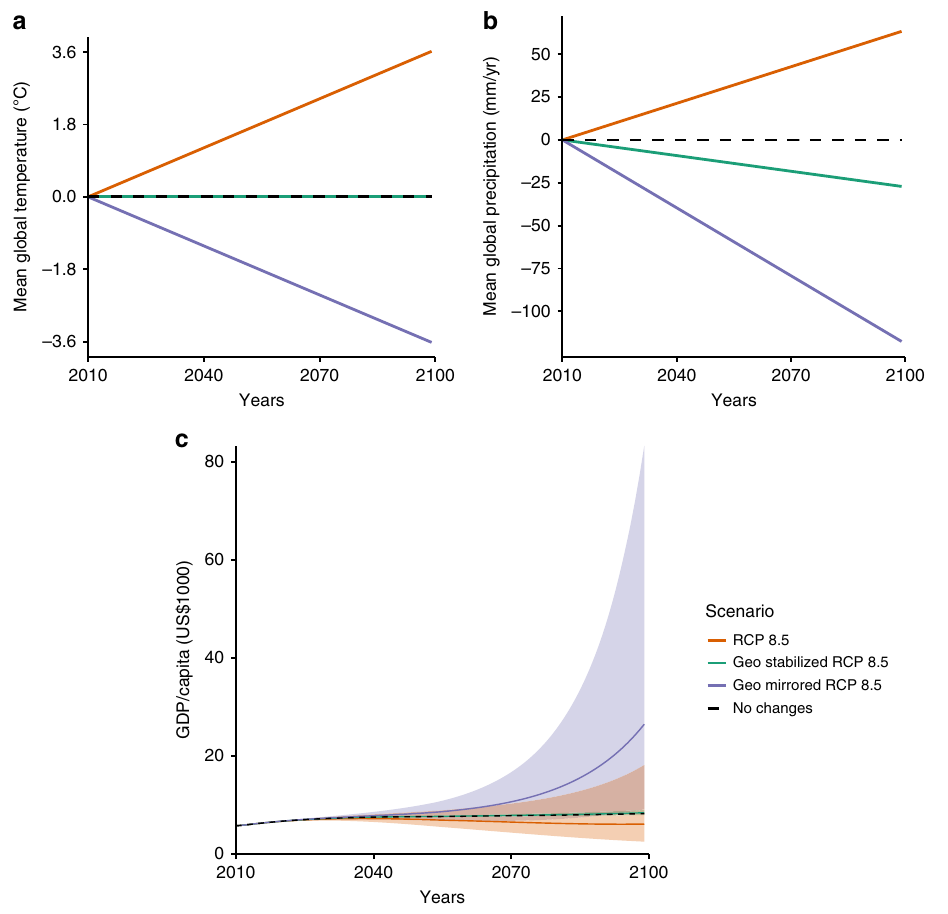
Fig. 1 Simulated changes in climate and projected GDP/capita over the 21st century. Curves are estimated using the model in column (1) of Supplementary Table 1 for Shared Socioeconomic Pathway (SSP) 3. a Change in global mean temperature and b change in global mean precipitation under the four illustrative climate scenarios. c Projected GDP/capita for the four illustrative climate scenarios where lines represent median projections and shaded area represents 95% con fi dence (See the “ Methods ” section). See Supplementary Materials for other SSPs, climate-economy model speci fi cations (Supplementary Fig.